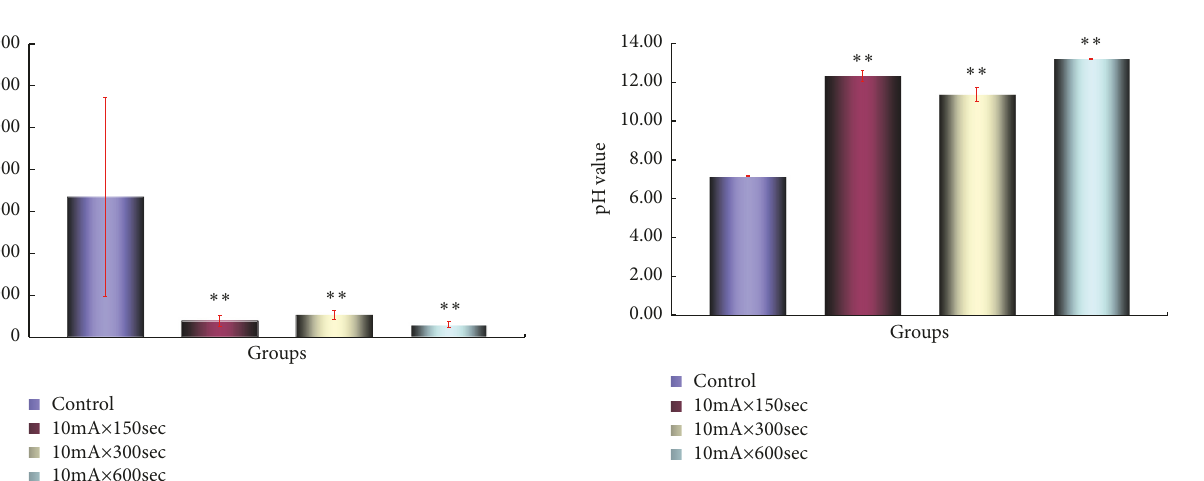
Figure 8: Tumor growth-inhibitory effect of ECT in Ehrlich carcinoma cells-bearing mice. Changes in the weight of the tumor. After tumor implantation, we measured the weight of the fifth week of the tumor of each group. The results represent ± S.D. from 8 to 10 mice. ∗∗ Significantly different from the control group ( p < 0.01 ).